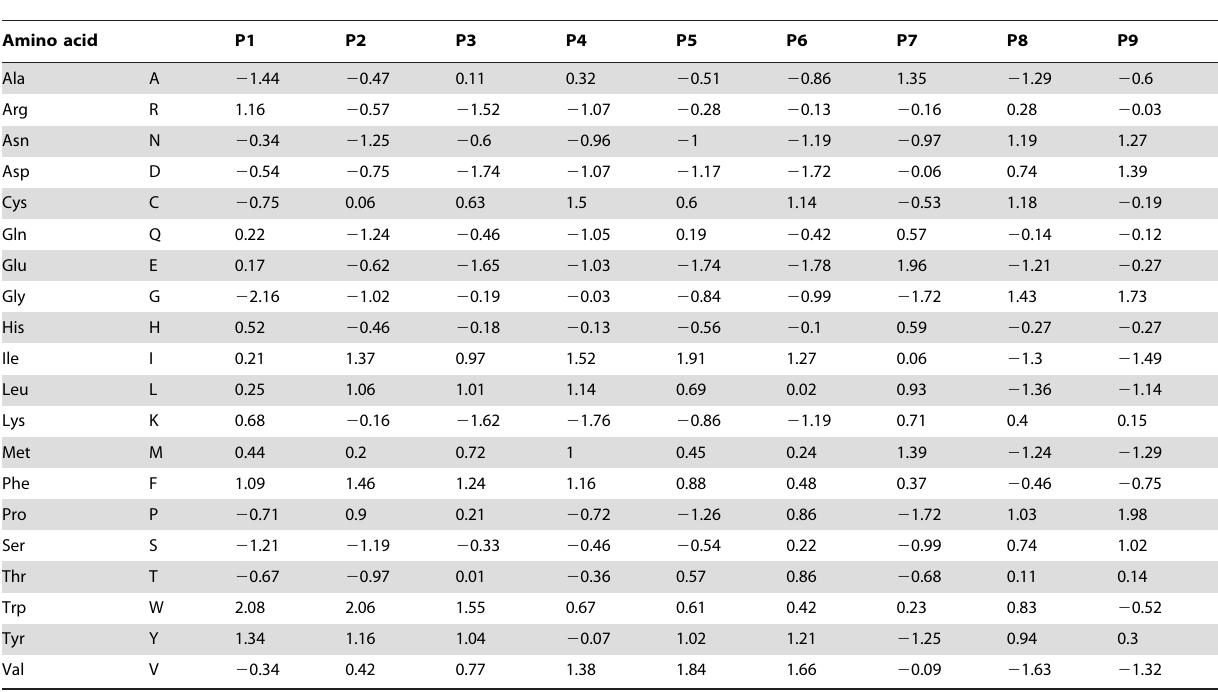
Table 1. The value of each amino acid according to 9 different physiochemical property scales.